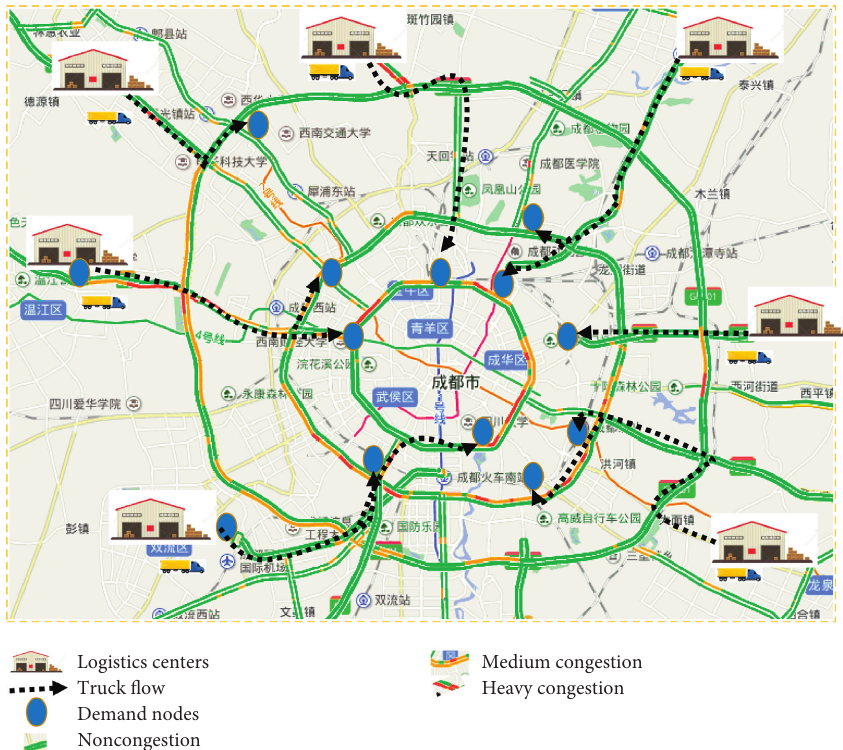
Figure 1: Real logistics network and background traffic